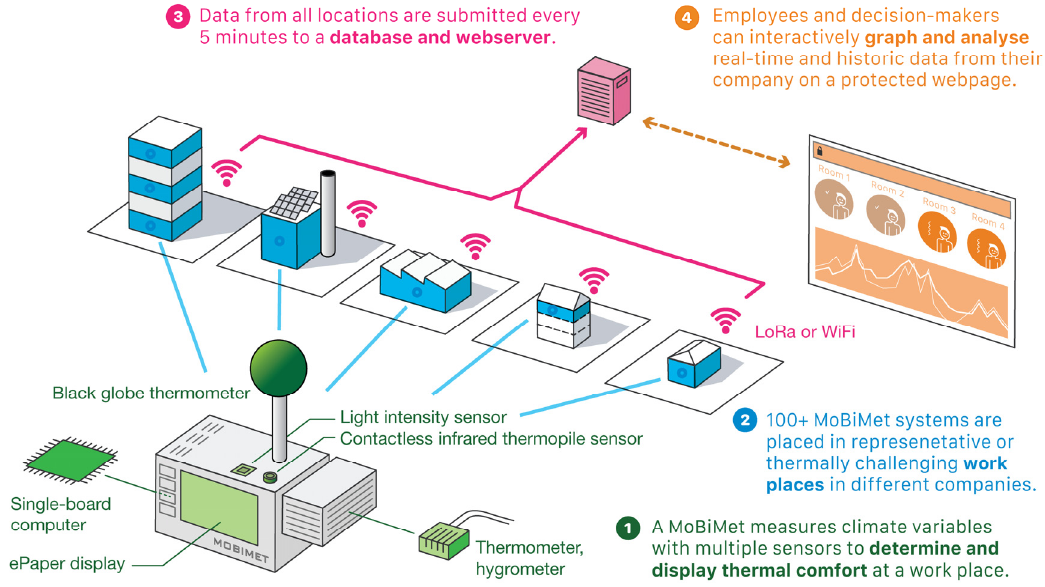
Figure 3. Structure of the MoBiMet network (at semi-outdoor locations, an additional cup anemome- ter is attached to the MoBiMet).